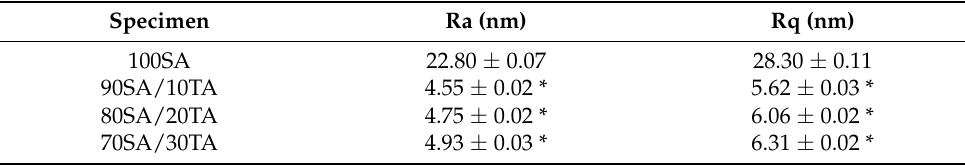
Figure 2. SEM images of cross-section of films composed of ( A ) 100SA ( B ) 90SA/10TA ( C ) Table 1. Roughness parameters (Ra and Rq) of sodium alginate/tannic acid films (n = 5; * significantly 80SA/20TA ( D ) 70SA/30TA . different from 100SA— p < 0.05).